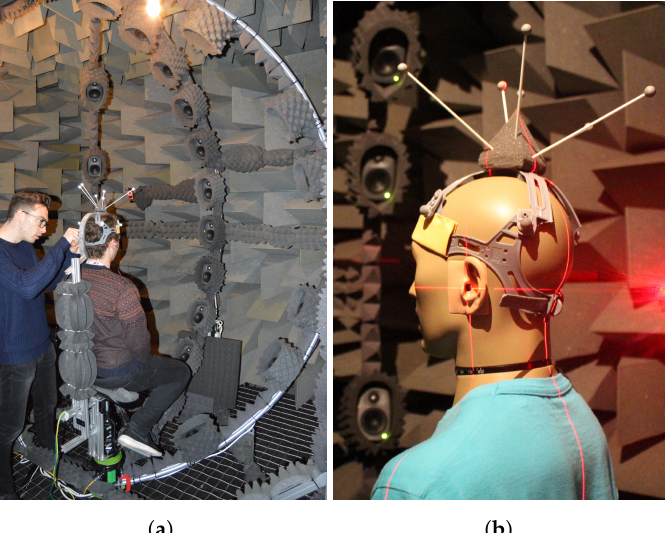
Figure 2. ( a ) a subject being prepared for HRTF measurements. They are sat on a motor-controlled rotating ‘saddle stool’ and their head movement has been restricted by a motion tracked restraint; ( b ) an example of the cross-axis laser guids used to align a subject’s interaural axis to the centre of the loudspeaker array.